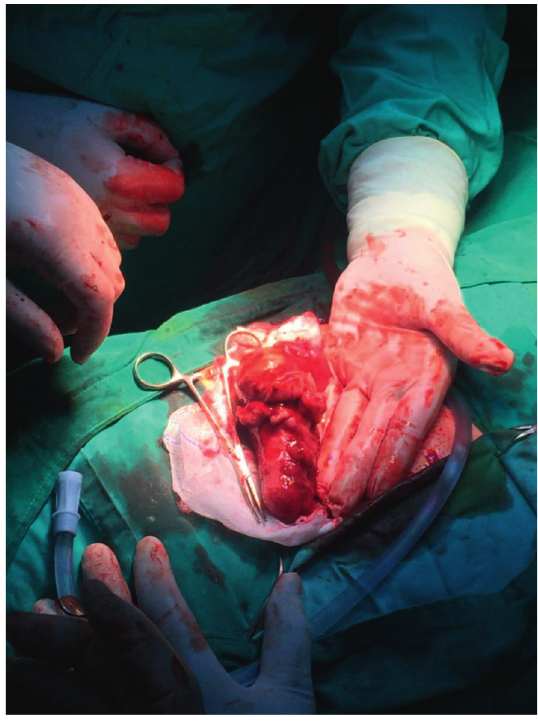
Figure 1: The appendiceal mass found intraoperatively.